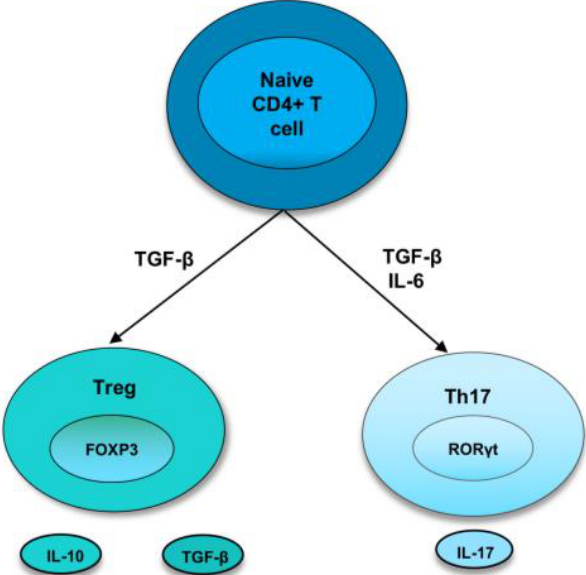
Figure 1. Differentiation of naive T cells into Th17 and Treg cells. In naive CD4 + T cells, TGF- β induce the development of Tregs by promoting Foxp3 expression. Treg cells express cytokines, IL-10 and TGF- β . However, in the presence of IL-6 and TGF β , ROR γ t is induced, leading to a Th17 phenotype.